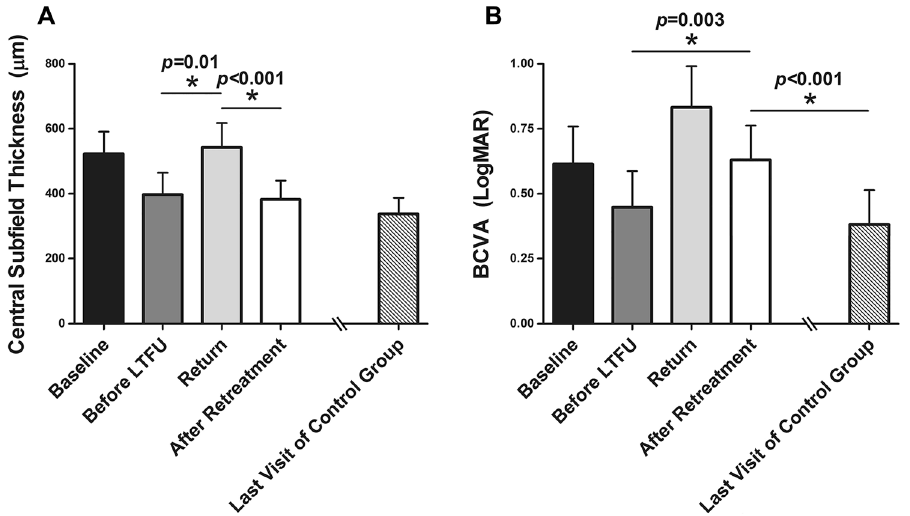
Figure 2. Visual and anatomical prognosis of DME patients lost to follow-up. ( A ) Central subfield thickness (CST) change in DME patients with loss to follow-up (LTFU). At the return visit, the CST was worse than the CST before LTFU. After re-treatment, the CST recovered to the level before LTFU. The CST after re-treatment in the return group was not different from the CST at the last visit of the control group. ( B ) The BCVA of DME patients with LTFU. At the return visit, the BCVA was worse than the BCVA before LTFU. After re-treatment, the BCVA was improved but did not recover to the level before LTFU. Moreover, when compared to the last visit of the control group, the BCVA after re-treatment in the return group was significantly